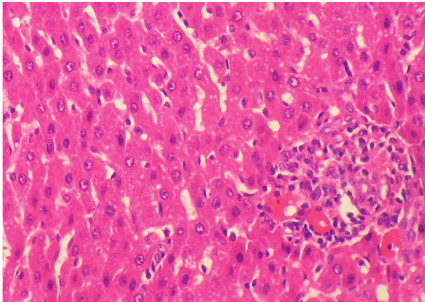
Figure 11: Histopathologic sections of liver (HE, x200), A: control group. Figures 10 and 11 showed many inflammatory cells infil- tration in portal area, hepatic endothelial cells hyperplasia, vacuo- lar degeneration, and punctate necrosis of hepatic cells in control group.